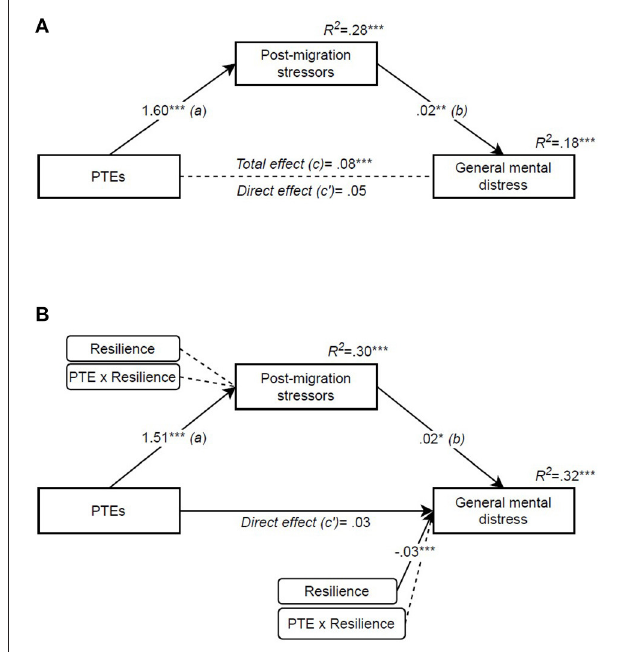
FIGURE 4 | Potentially traumatic events’ effect on general mental distress mediated by post-migration stressors and moderated by resilience. (A) Mediation (PROCESS model 4), (B) Moderated mediation (PROCESS model 8). Independent variable: PTE [potentially traumatic events (RTHC)]. Mediator: post-migration stressors (RPMSS). Outcome: general mental distress (HSCL-10). Moderator: resilience (CYRM-12). Covariate: gender. All coefficients are unstandardized. * p < 0.05, ** p < 0.01, *** p <